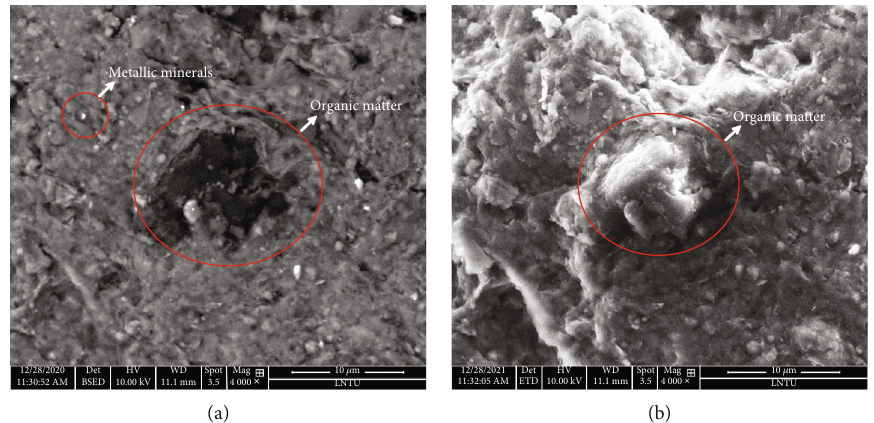
Figure 4: (a) Backscatter image at the same position. (b) SEM image at the same position.